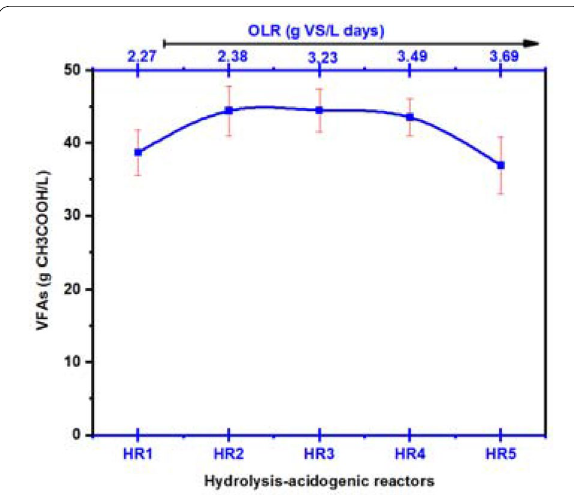
Fig. 3 The VFAs’ production with different mixing ratio in two-stage ASBR